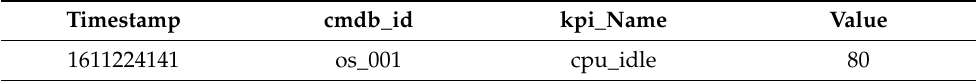
Table 2. Example of monitoring indicator data